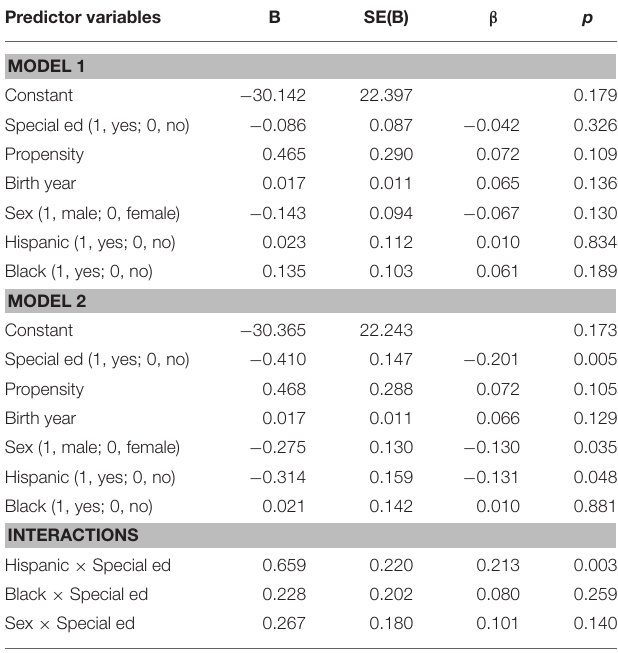
TABLE 8 | Hierarchical multiple logistic regression analyses predicting use of any public assistance ( n = 586). Predictor variables